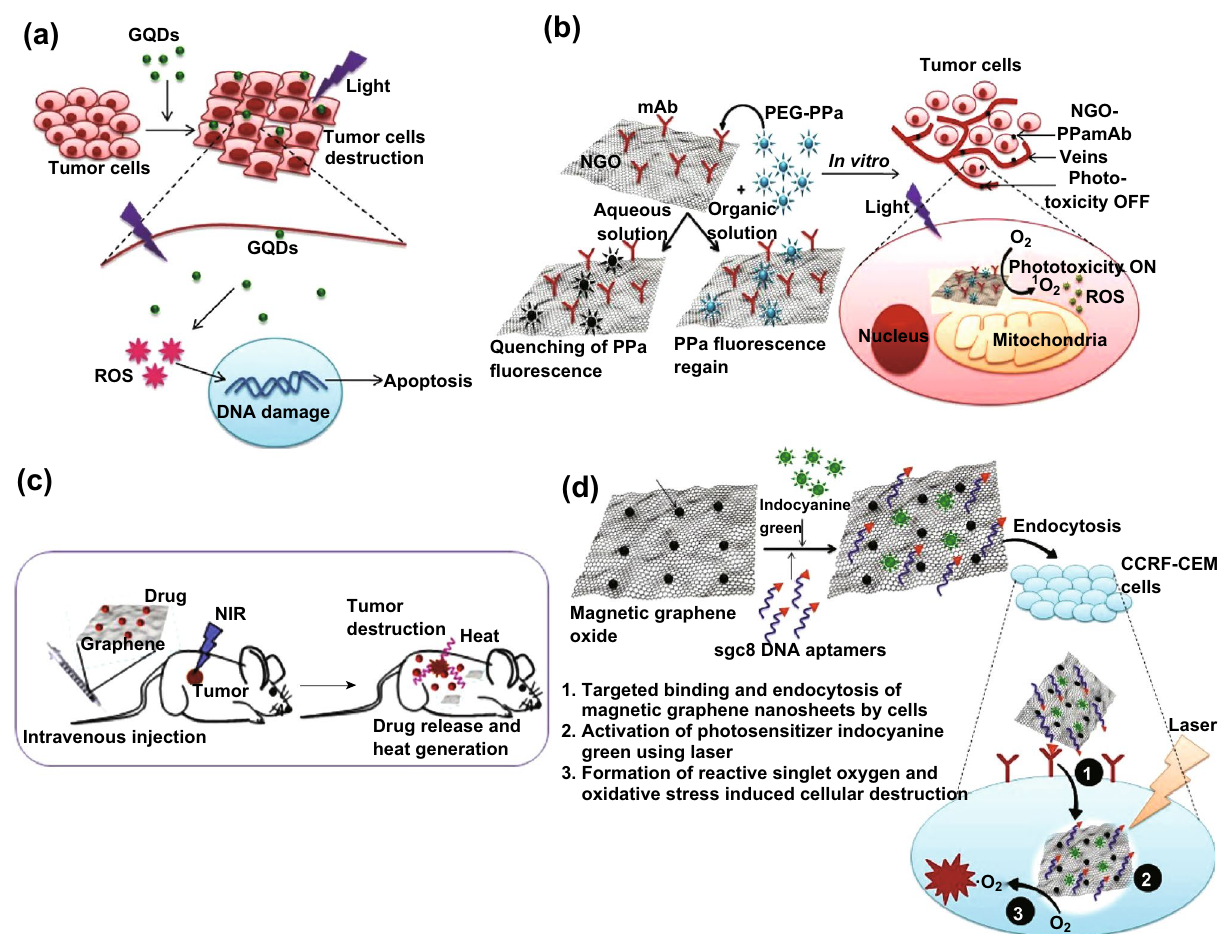
Fig. 3 Anticancer therapy. a Photothermal destruction of tumor cells following GQD exposure and irradiation. b Development of the phototox- icity on/off system for subcellular targeting and selective destruction of tumor cells. c Combined chemo- and photothermal destruction of tumor cells using drug-loaded graphene nanosheets under NIR irradiation. d Photodynamic therapy using magnetic GO nanoconjugates functionalized with aptamer and an ICG photosensitizer to achieve targeted cancer cell